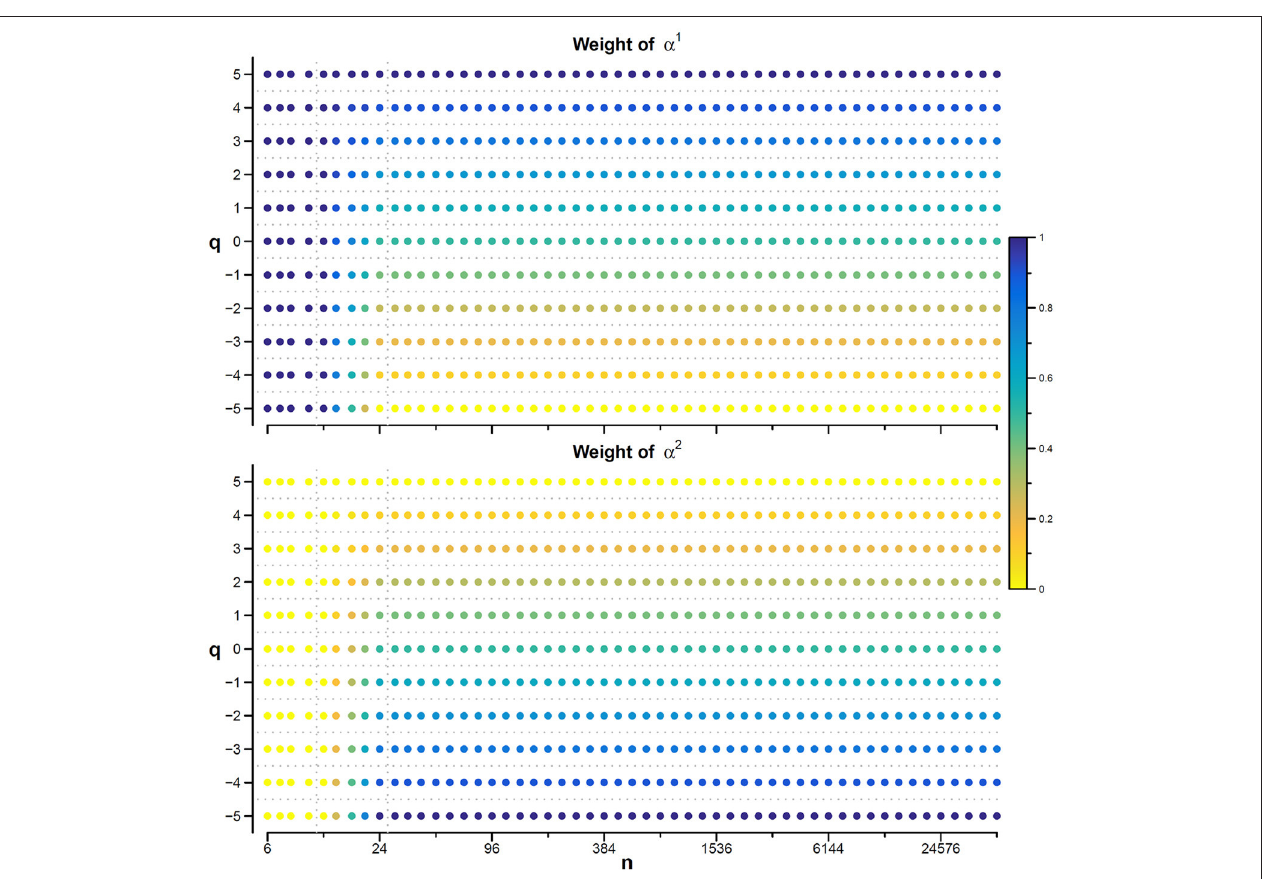
Frontiers in Physiology |